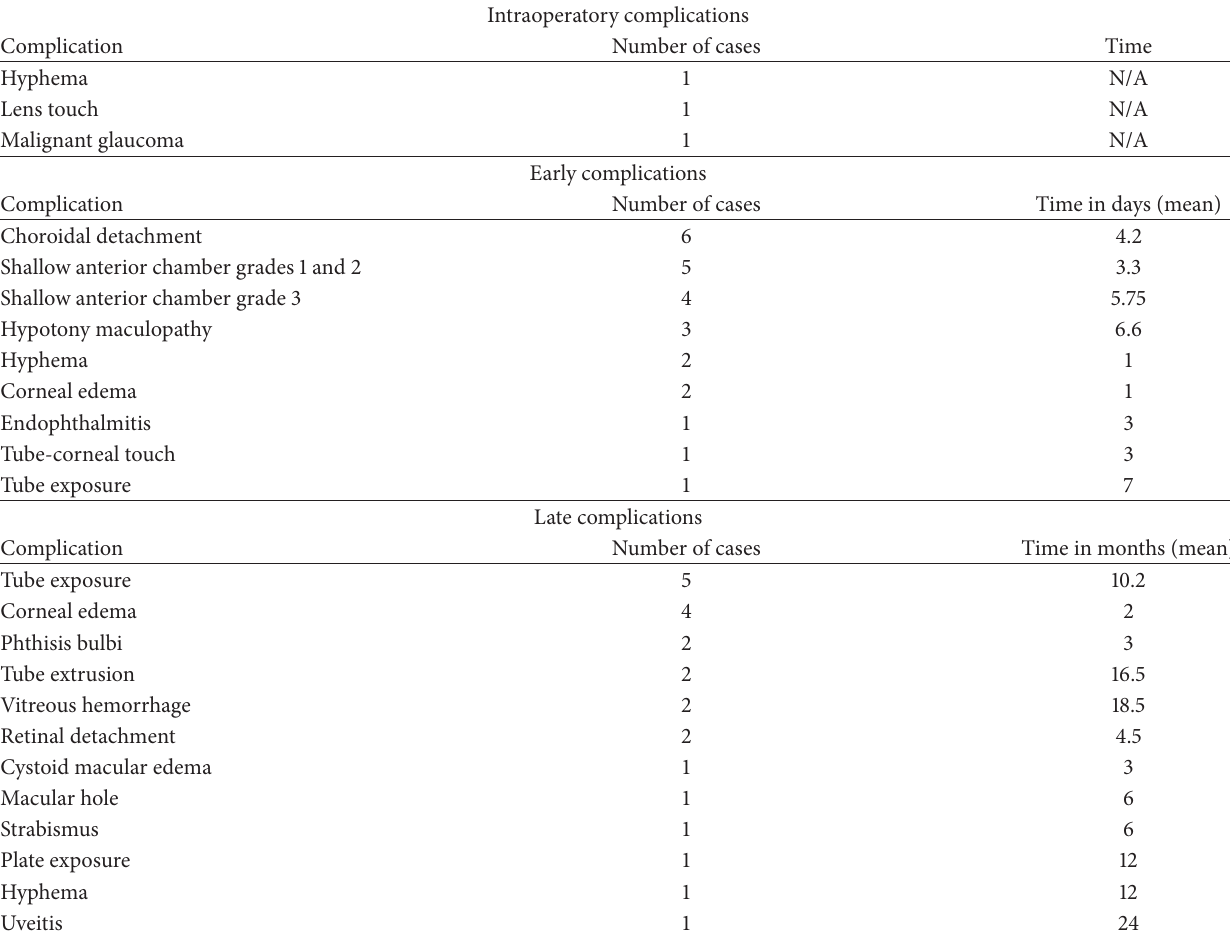
Table 4: Intraoperatory, early and late complications related to Ahmed Glaucoma Valve